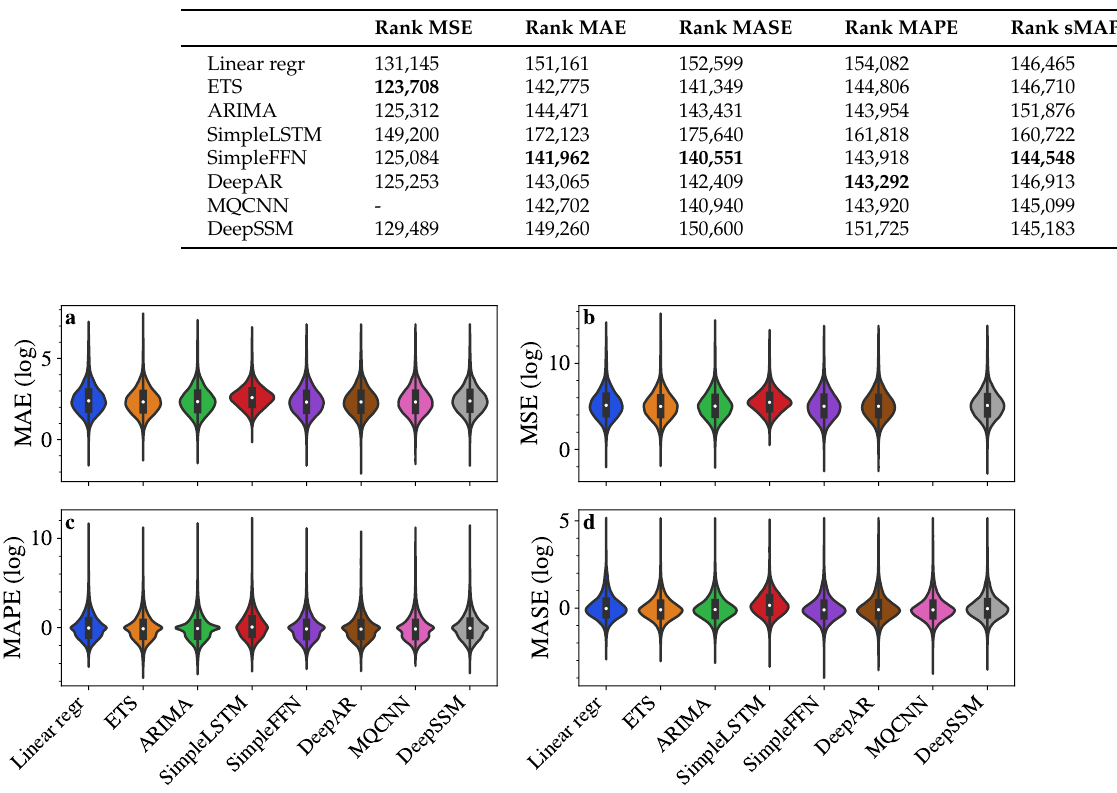
Figure 4. Log-normalized density-kernel estimations for four types of error measures. The error metrics are computed over a forecast horizon H = 7 years. ( a ) MAE; ( b ) MSE; ( c ) MAPE; ( d )